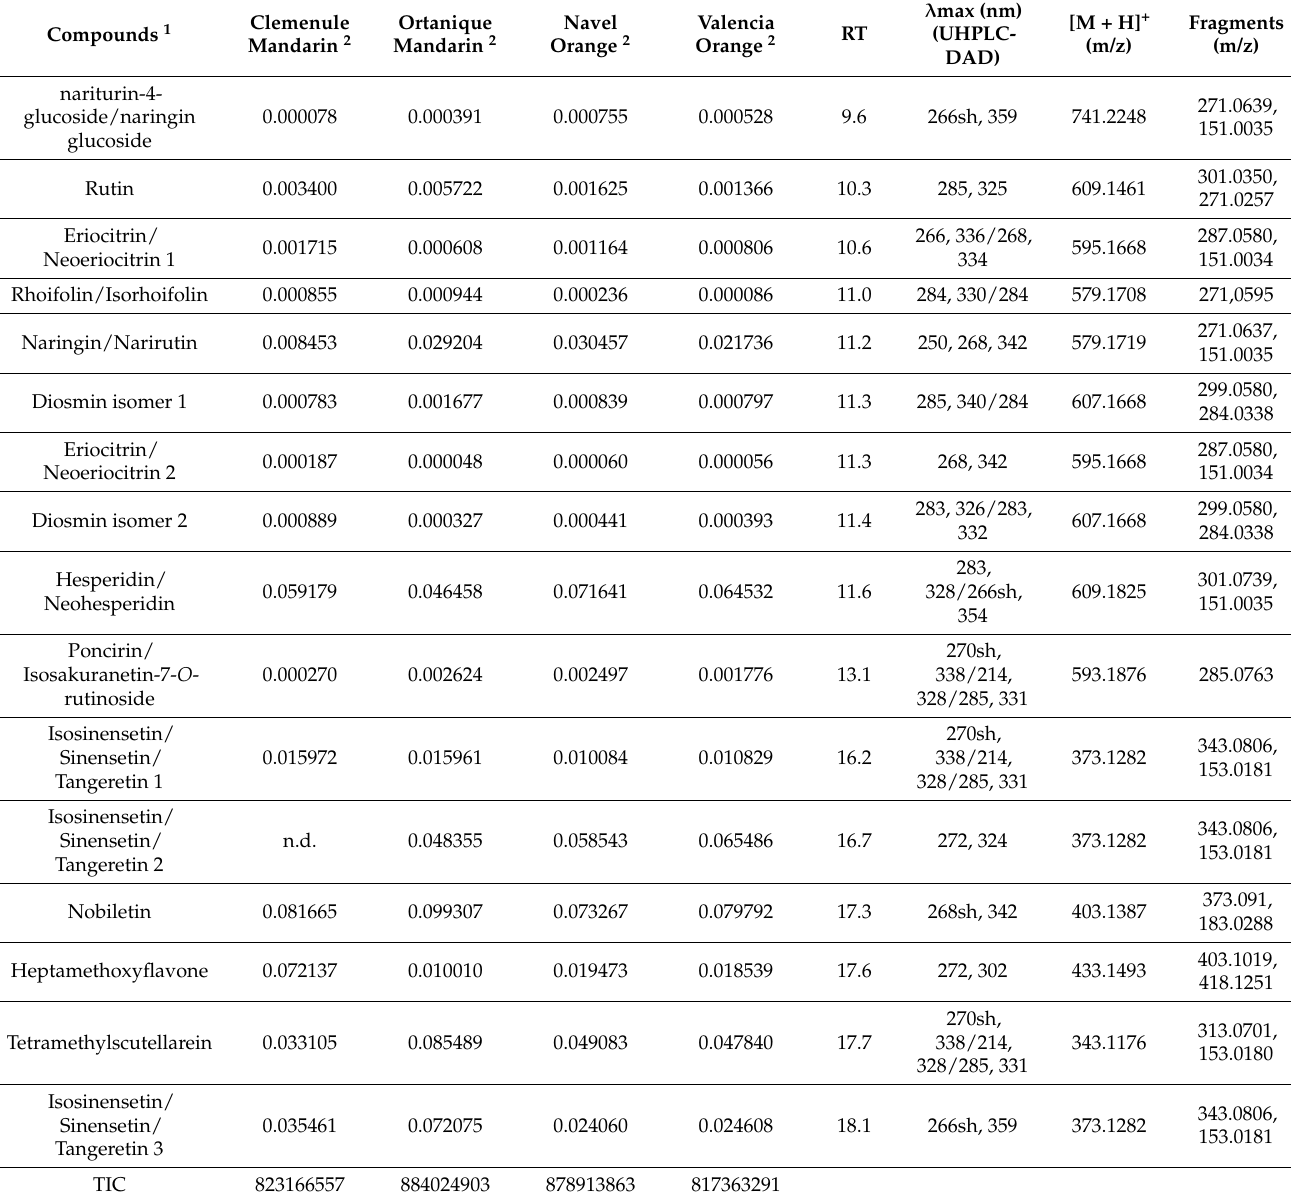
Table 1. Data on identification of phenolic compounds composing citrus